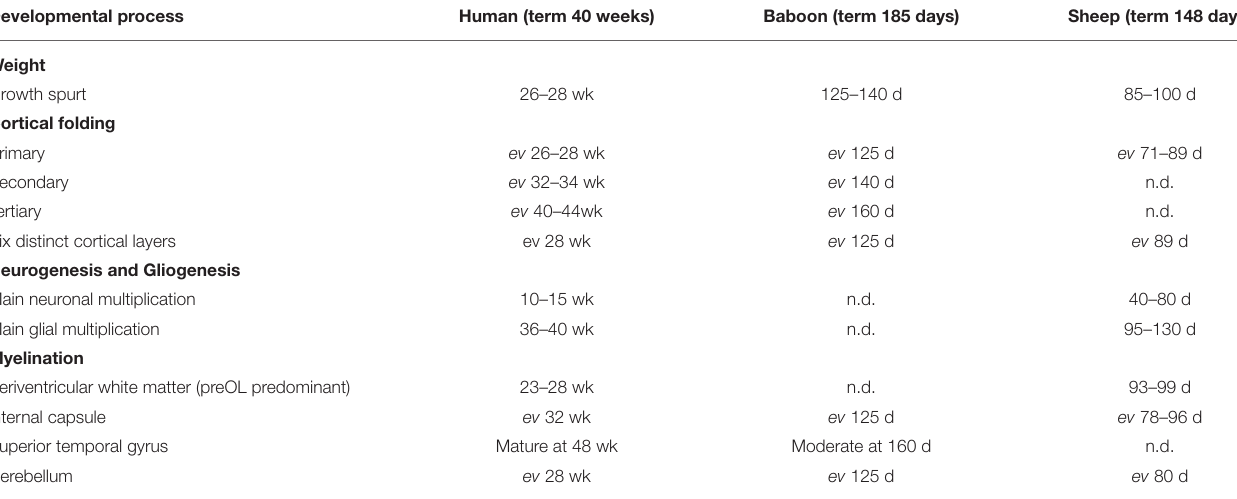
TABLE 1 | Comparative gestational ages for key brain development processes in the human, baboon, and